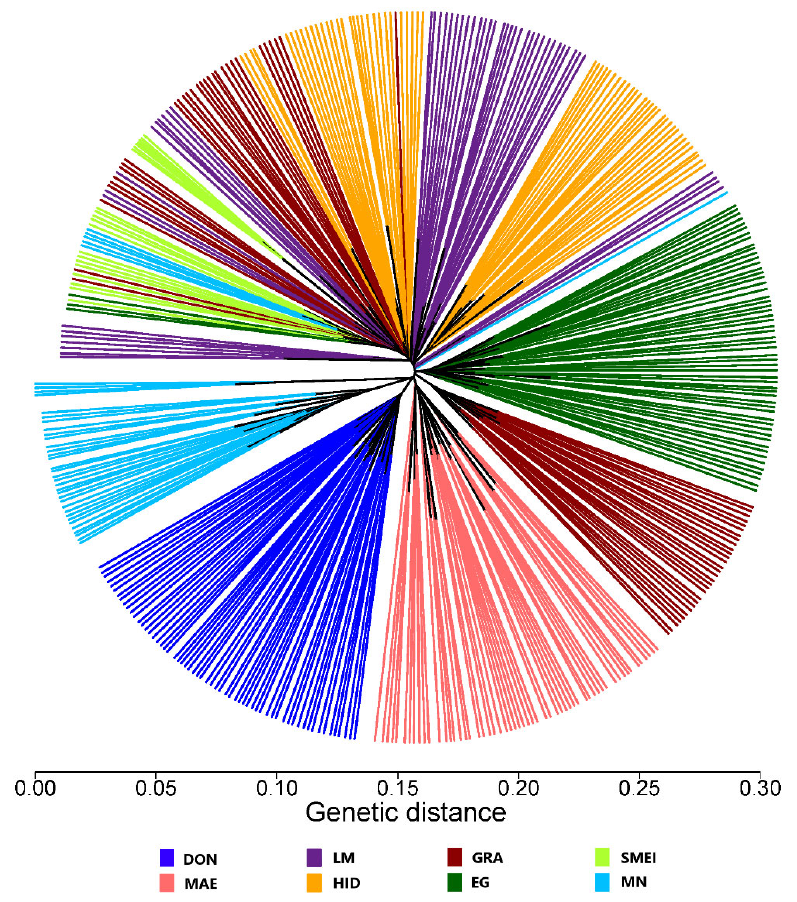
Figure 5. Unrooted tree of genetic distances between individuals of the historical lines of the Spanish Merino and MN. Genetic lines within the Spanish Merino: DON (Donoso), EG (Egea), GRA (Granda), HID (Hidalgo), MAE (Maesso), LM (L ó pez-Montenegro), SMEI (Spanish Merino from Industrial Breeding). Breed: MN (Spanish Black Merino).